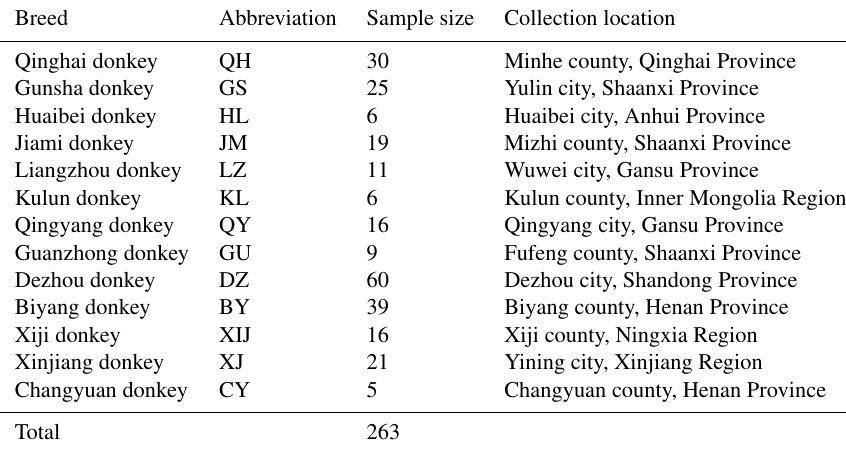
Table 1. Sample information of 13 donkey breeds in China. Breed